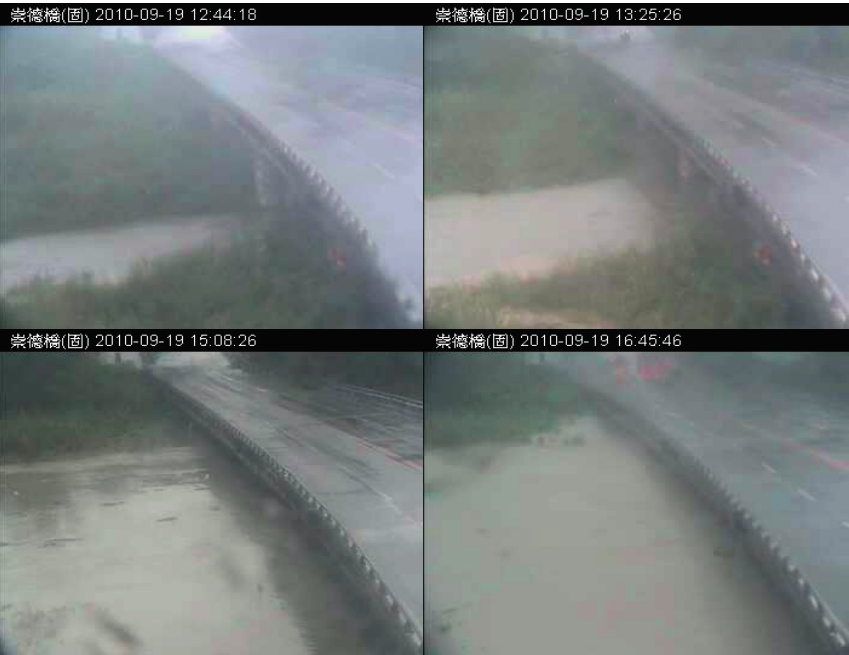
Figure 4. Video screenshots from the water-level detection test. This figure has four best-quality images showing representative overflow changes. From top-left to bottom-right, the acquisition time of the four images is 12:44, 13:25, 15:08, and 16:45, respectively. The content of the experiment is the real video of Typhoon Fanapi taken on 19 September 2010, from 12:00 to 18:00 in the afternoon. The experimental images were captured every 1 min during this period, with a total of 350